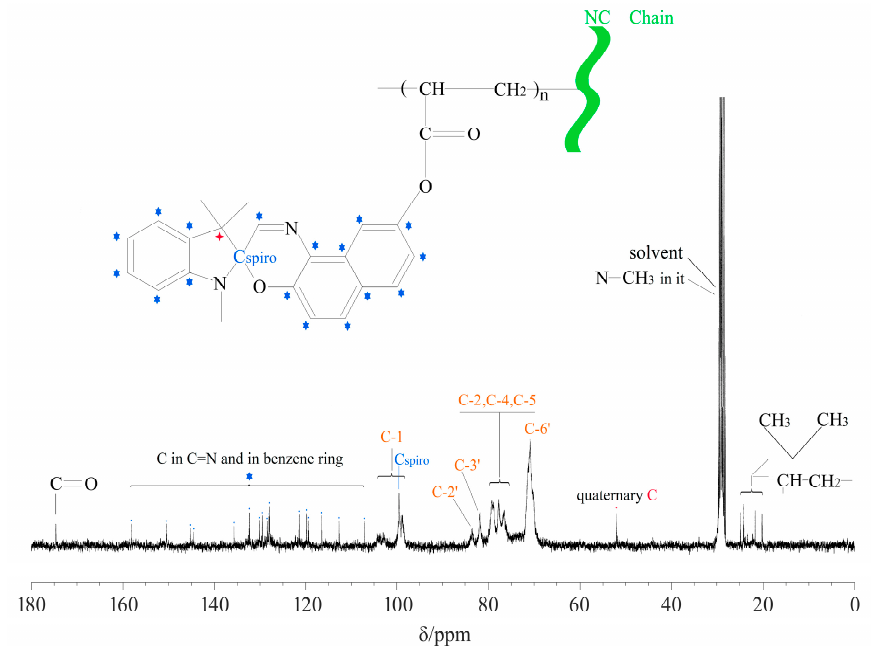
Figure 6. 13 C NMR spectra of NC-g-AISO. Coatings 2020 , 10 , x FOR PEER REVIEW